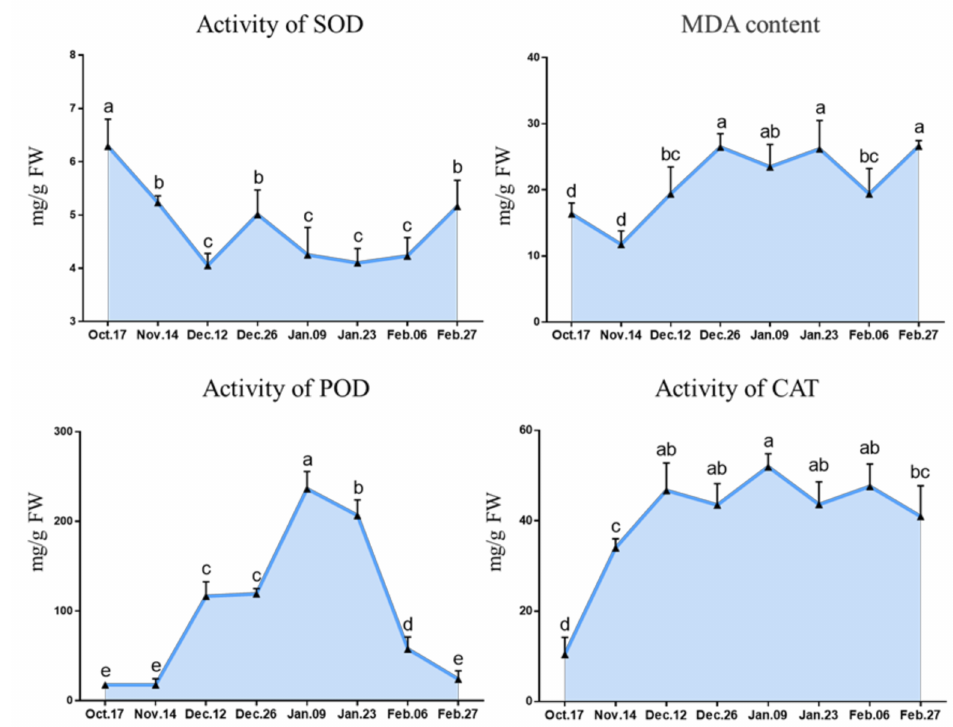
Figure 7. Antioxidant metabolic enzyme activity and MDA content in underground buds of ‘Meiju’ at different dormancy stage. Different letters indicate a significant difference among different dates ( p < 0.05). The experimental time was from 2018 to 2019, and the data were processed by IBM SPSS Statistics